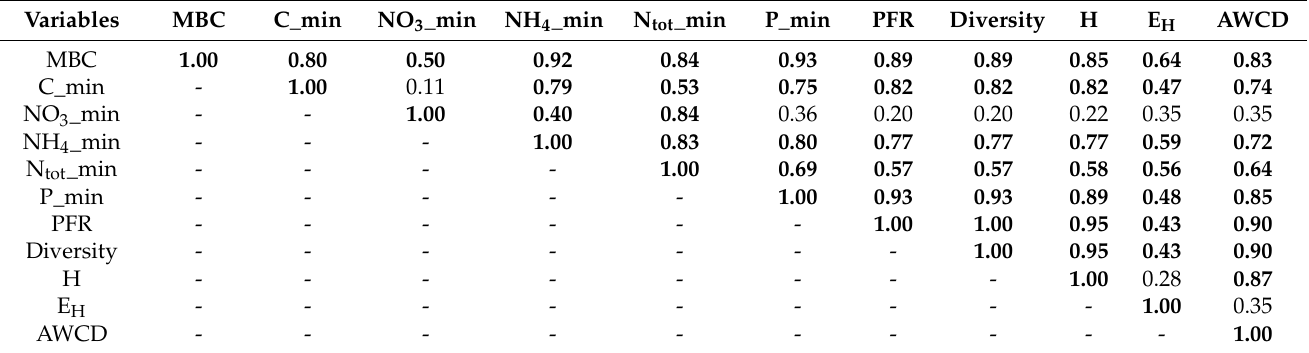
Table 5. Pearson correlation coefficients ( n = 30) between microbial biomass carbon (MBC), mineral- ization rates and microbial catabolic diversity parameters; bold values are significant at p <